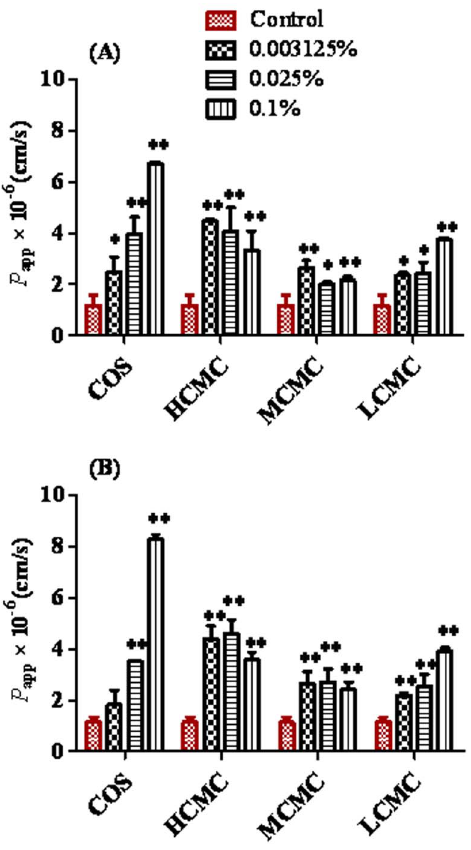
Figure 3. Effects of CMCs and COS on absorption parameters of FTA and CHA in Caco-2 cell invitro model. Results are expressed as the mean 6 S.D. ( * ) P , 0.05 and ( ** ) P , 0.01 compared with the control group (A: FTA; B: CHA).